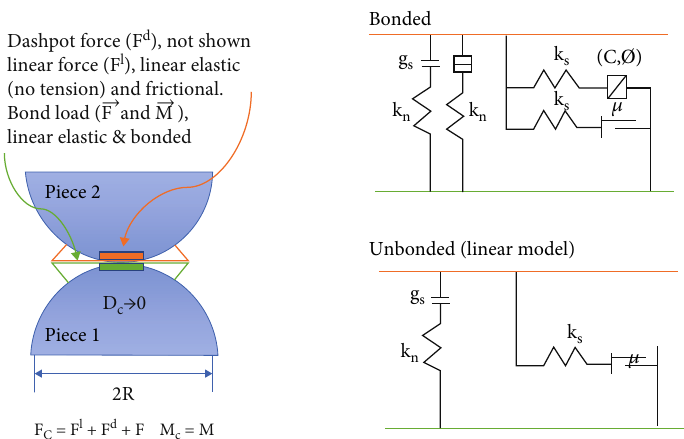
Figure 3: Behavior and rheological components of the linear parallel bond model with inactive dashpots.